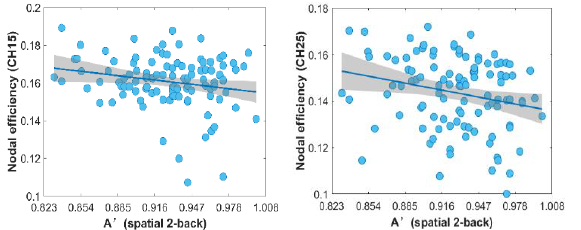
Figure 7. Correlation between behavioral performance (2-back A’) and network properties in the Xining group.